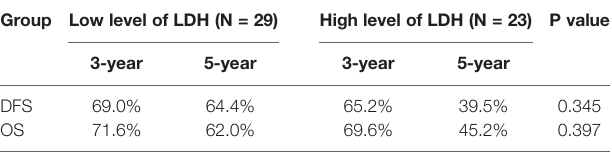
TABLE 8 | Multivariate analysis of DFS and OS for patients with T3 –